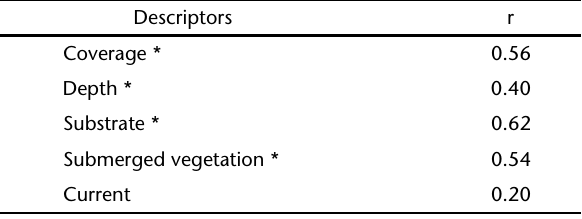
Table III. Correlation coefficient (r) obtained by the Mantel test for microhabitat descriptors and K. moenkhausii abundance. * Probability <